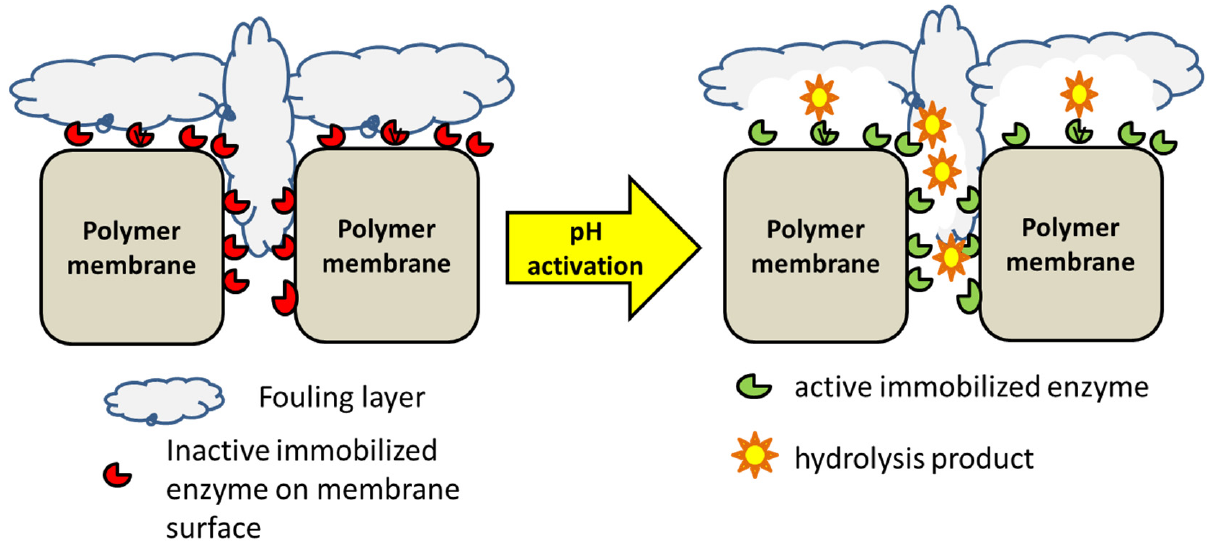
Figure 5. Schematic mechanism of self-cleaning membranes. By altering the pH of the buffer, digestive enzymes immobilized on the membrane surface become active and break down the substrates that cause fouling. Reproduced from ref. [82] with permission of Elsevier.